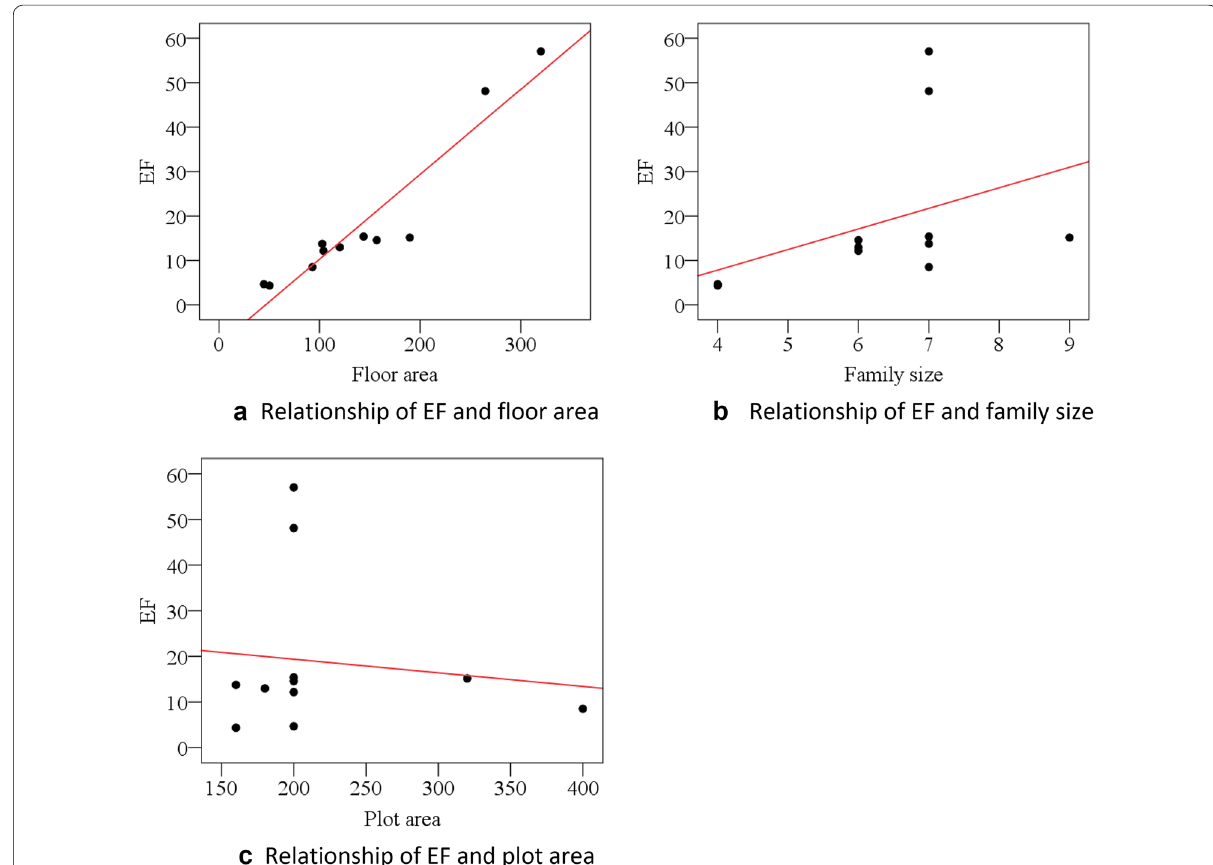
Fig. 7 Scatter plot of EF against the three explanatory variables floor area ( a ), family size ( b ), plot area ( c ) and overlaid with best fit regression line